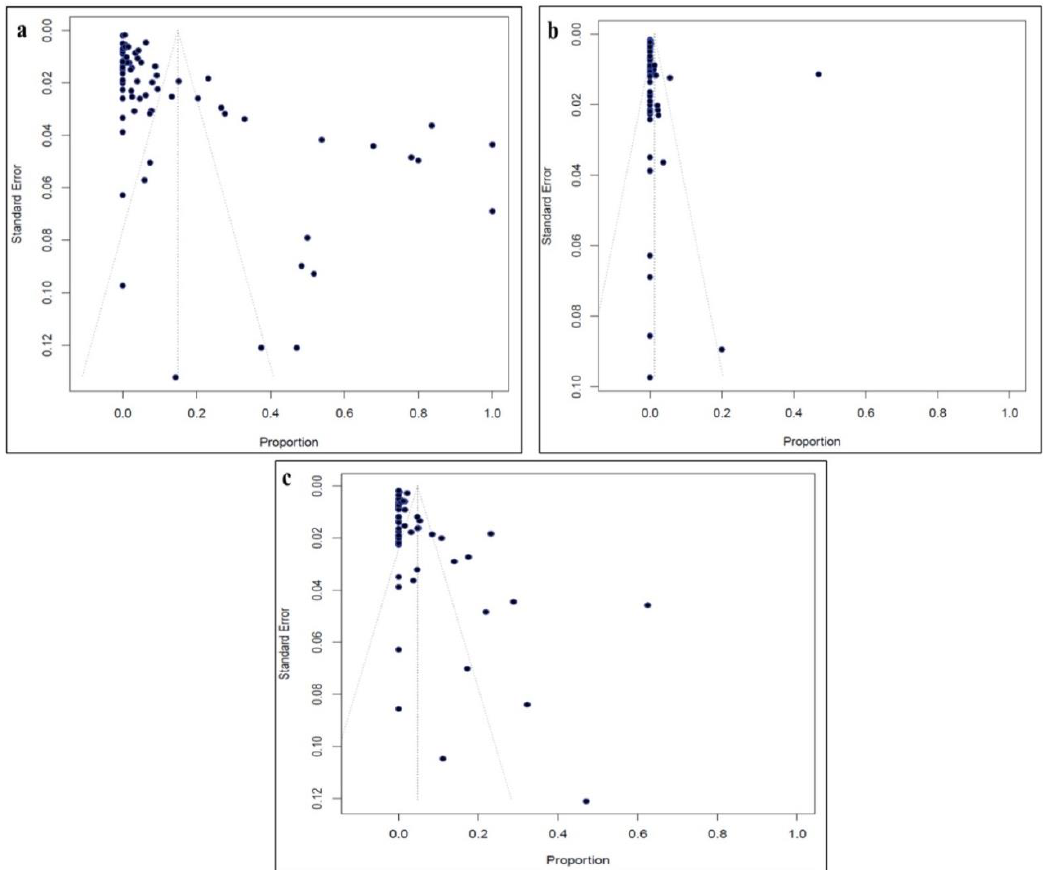
Figure 4. Forest plot representing the pooled prevalence of Voriconazole-Resistant Candida parapsilo- sis isolates.